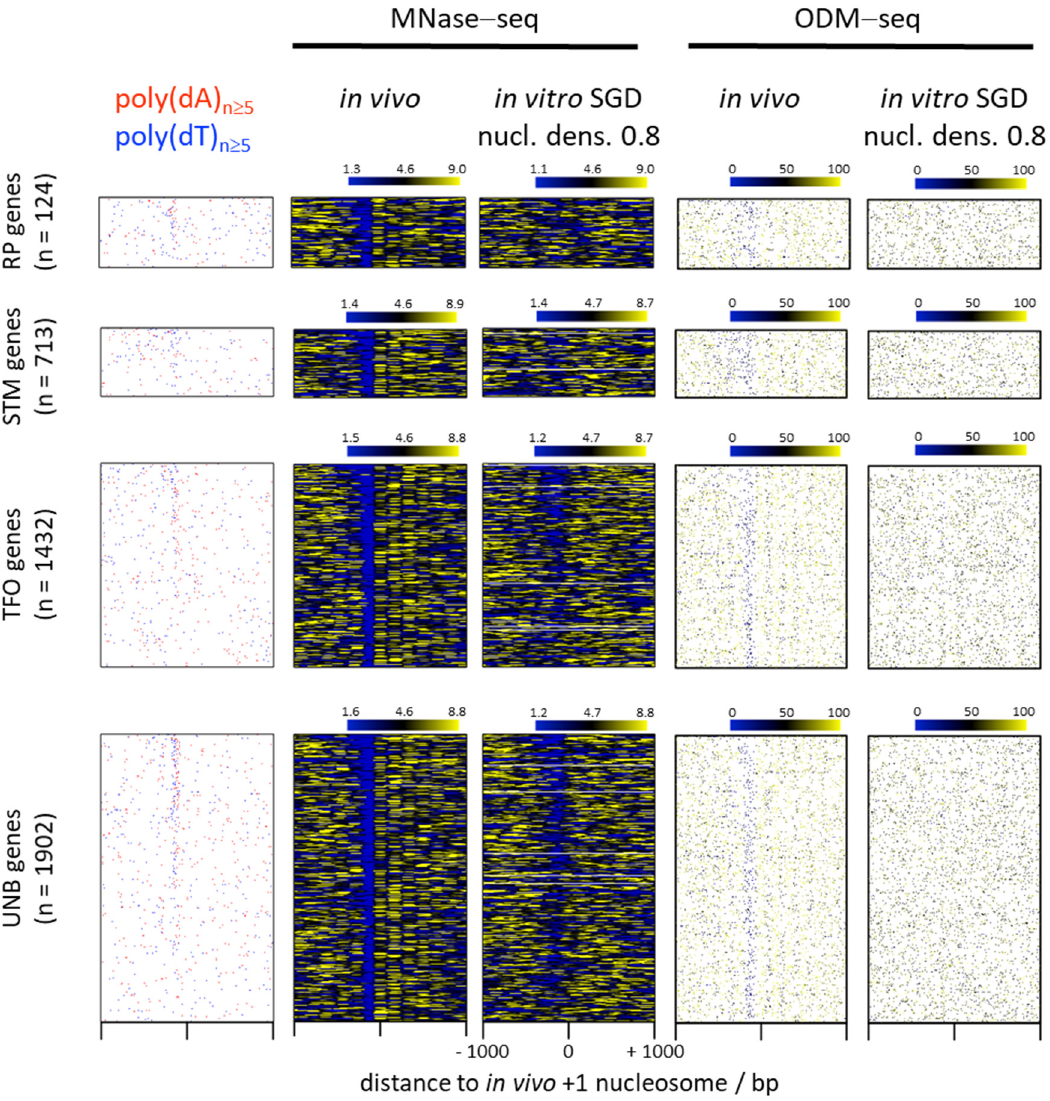
Figure 1. Correlation of poly(dA)/poly(dT) tract occurrence with low nucleosome occupancy in in vivo chromatin or in in vitro salt gradient dialysis (SGD) reconstituted chromatin monitored by MNase-seq or by DNA methylation footprinting (ODM-seq). Intrinsic nucleosome depletion over poly(dA)/poly(dT) tracts in SGD chromatin relative to the in vivo depletion in S. cerevisiae is less pronounced if monitored by ODM-seq than previously seen by MNase-seq [30–32]. From left to right: heatmaps (linked rows) of poly(dA)/poly(dT) tract occurrence on the coding strand, MNase-seq and ODM-seq data, each of in vivo ( S. cerevisiae wild type BY4741) chromatin and of genome-wide in vitro salt gradient dialysis (SGD) chromatin reconstituted at a nucleosome